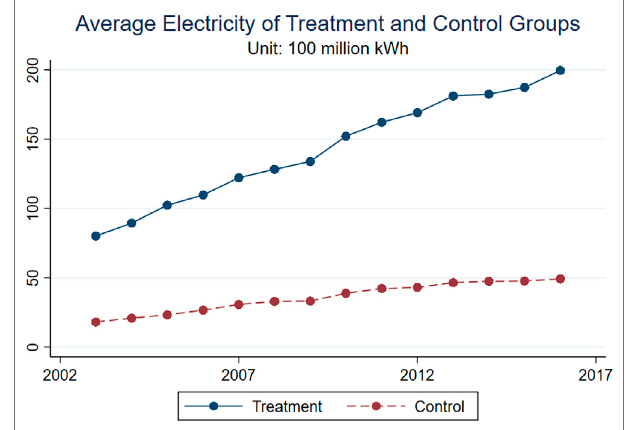
FIGURE 4 | Average electricity consumption of treatment and control groups.